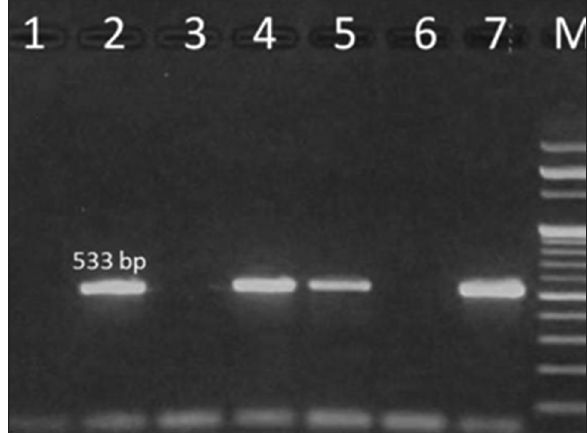
Figure-6: Polymerase chain reaction (PCR) amplification of mecA gene of Staphylococcus aureus isolates. Lane M: 100 bp ladder, Lane 1: Negative control having distilled water as template, Lane 2: Positive control of S. aureus showing PCR amplified product of 533 bp specific for mecA gene, Lane 4, 5, 7: S. aureus isolate from milk having mecA gene, Lane 3 and 6: S. aureus isolate from mastitic milk